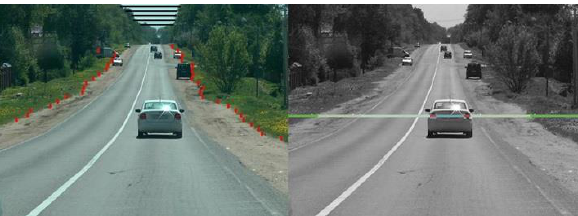
Figure 2 . Bunches of SearchLat( STG ) for a fixed strip.